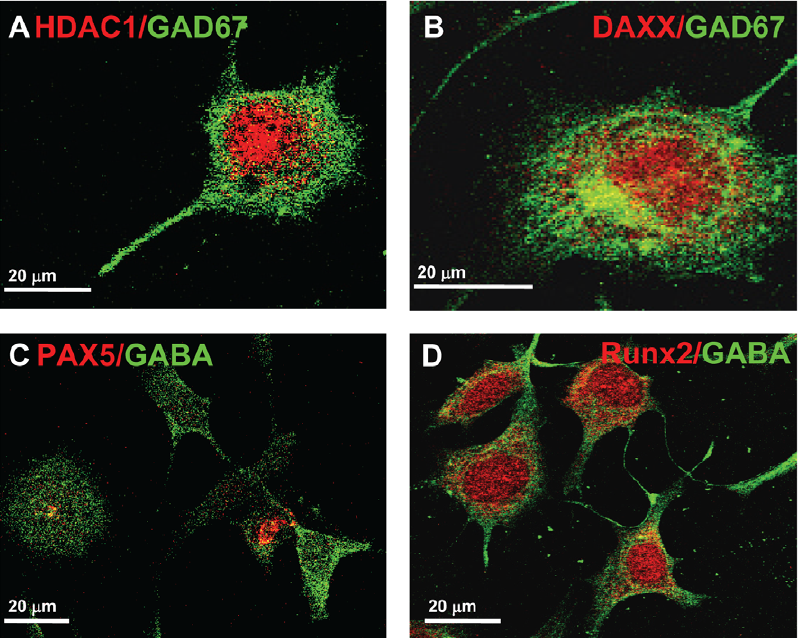
Figure 7. Co-localization of epigenetic regulators HDAC1 and DAXX, developmental transcription factors PAX5 and Runx2 with GAD 67 in differentiated HiB5 cells. Specific antibodies were used to detect several proteins expressed by the target genes associated with a GAD 67 regulatory network. GAD 67 (green) was co-localized with ( A ) HDAC1 (red); ( B ) DAXX (red) and GABA (green) with ( C ) PAX5 and ( D ) Runx2 (red fluorescence, respectively).